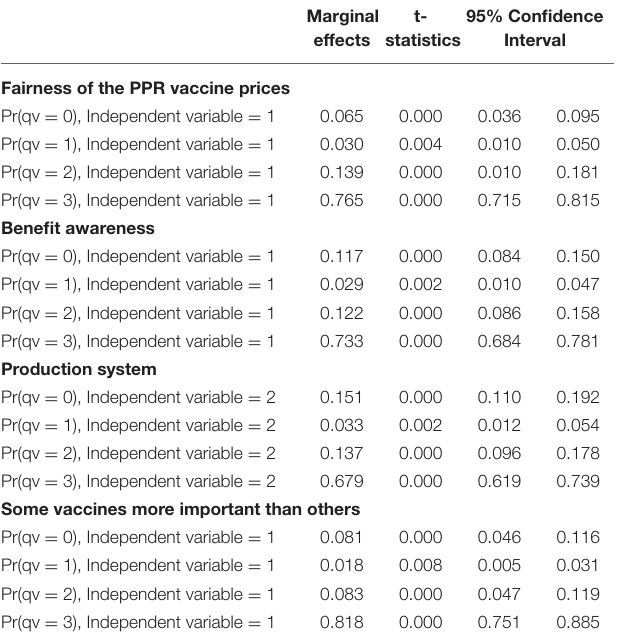
TABLE 10 | Marginal effects of the variables used in the model on quality parameter.